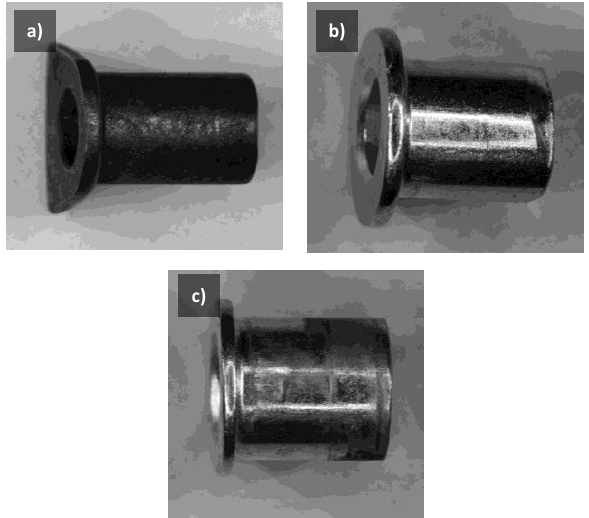
Fig. 4. The central fastening sleeve, which causes the mechanism to jam in the event of an accident, making it difficult to release the safety belts: a) original belts; b) c) imitation of original belts